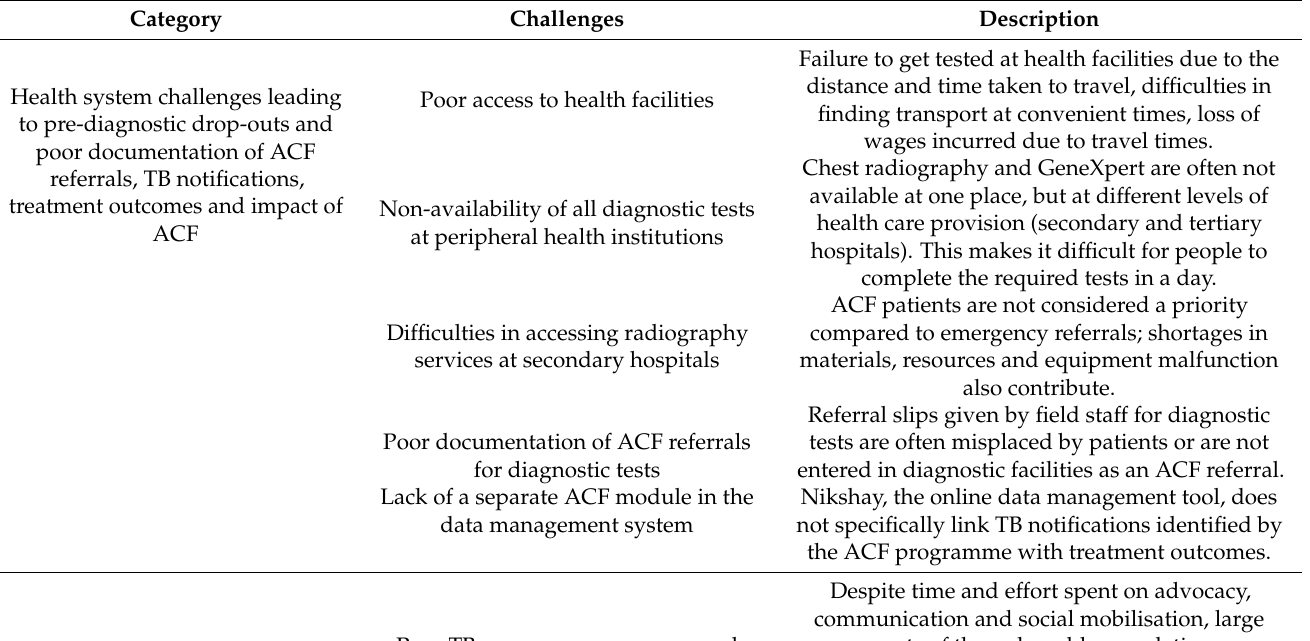
Table 5. Challenges in implementing ACF activities as perceived by